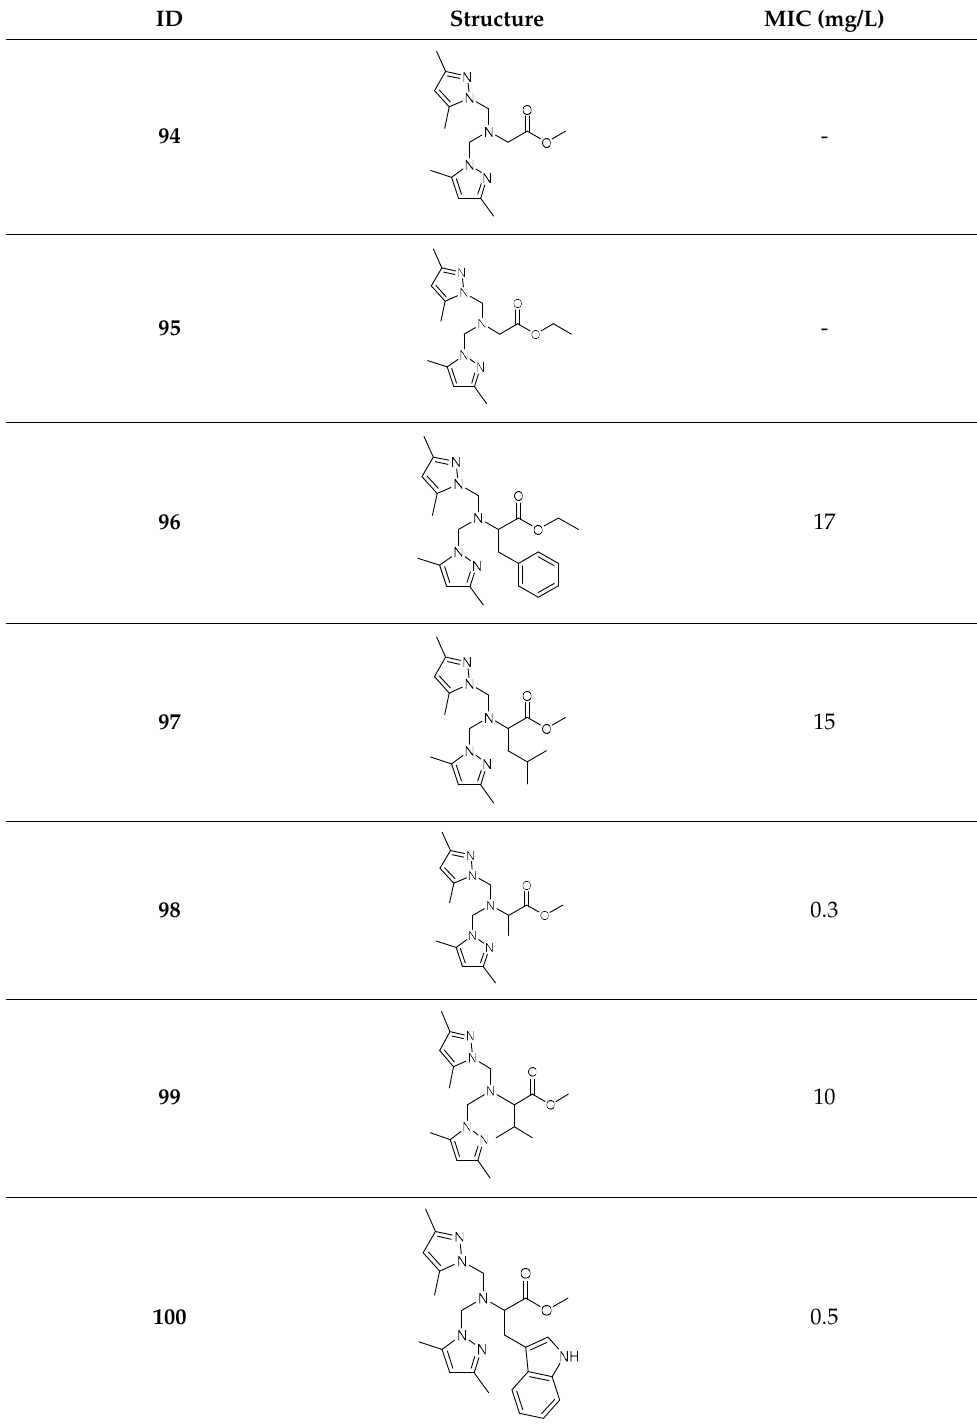
Table 12. MIC values of amino acids pyrazole compound tested against F.o.a.